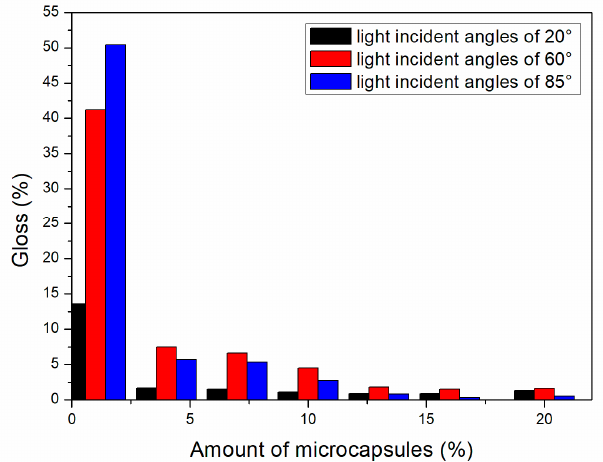
Figure 2. Effect of microcapsule content with the ratio of core materials to shell material in mass of 0.55 on gloss of coating film.